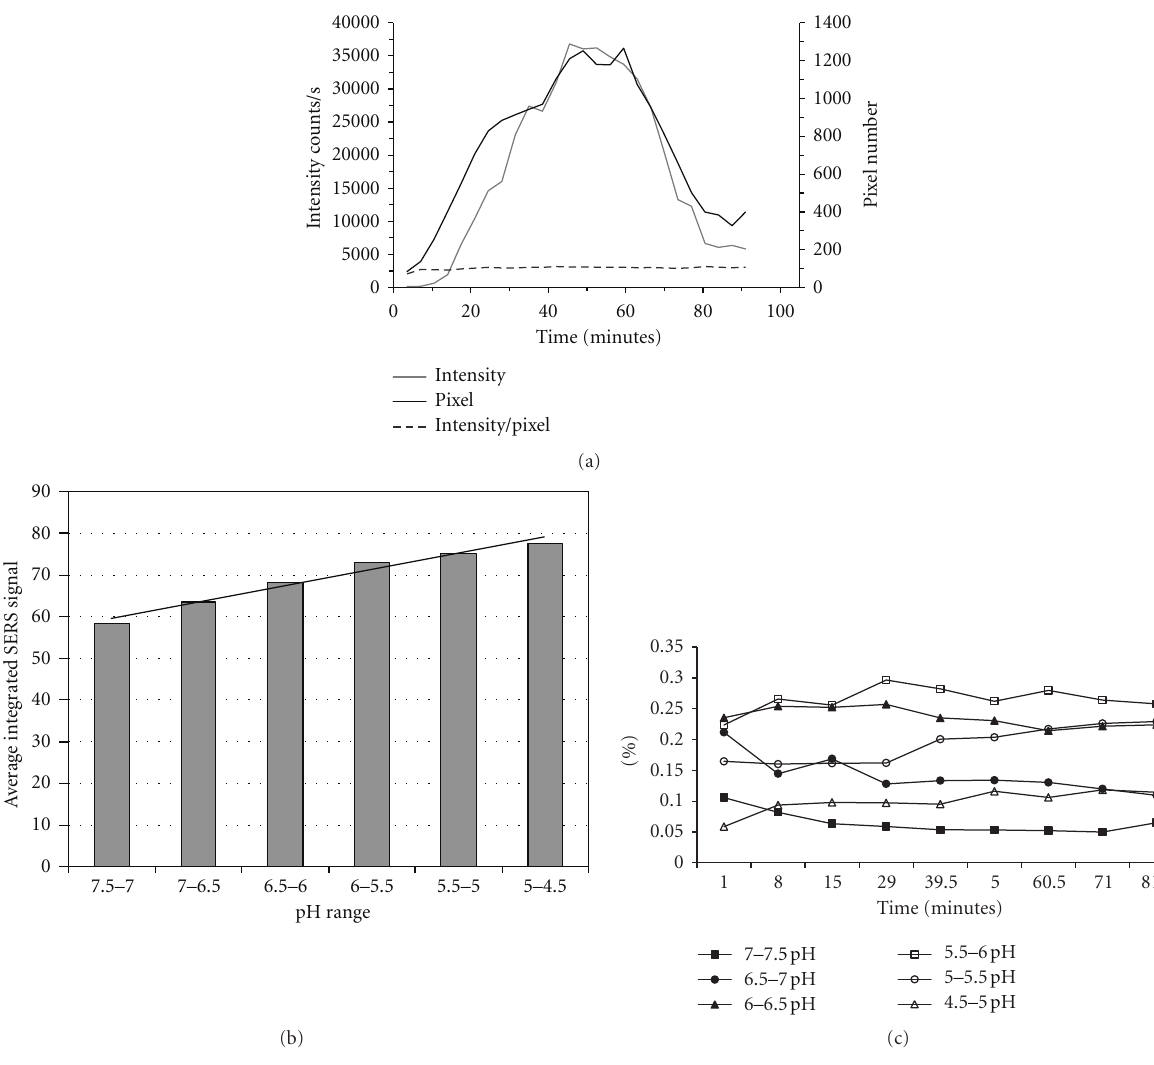
Figure 6: (a) Whole-cell image data ranging from 3.5 to 90 minutes. Total nanosensor intensity per image is depicted with gray line, corresponding to primary y axis. Total pixel count per image is shown with black line corresponding to secondary y axis. Average intensity per pixel is displayed with dashed line and also corresponds to secondary y axis. (b) Integrated SERS signal in the 1612 cm − 1 range as a function of pH normalized to total pyridine signal and averaged overtime. Line is linear fit to the data, to guide the eye. (c) Percentage of pixels representing each pH grouping. (a and c) Reprinted with permission from Nowak-Lovato et al. [11] (copyright 2009 Society for Applied Spectroscopy), (b) Reprinted with permission from Nowak-Lovato and Rector [12] (copyright 2009 Thomson